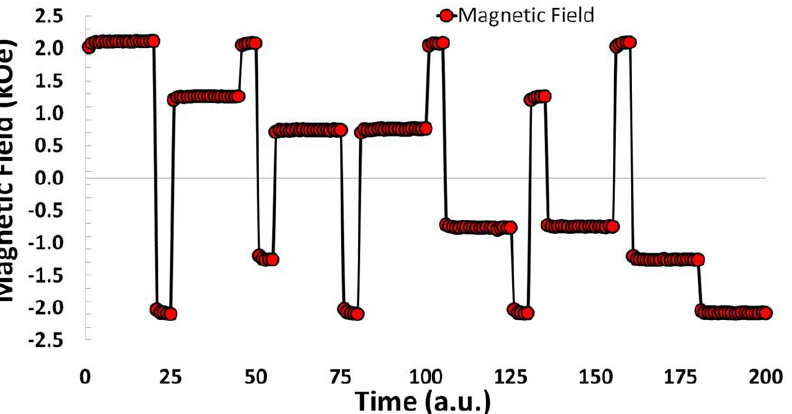
Figure 5. Modulated recording field. The sequence of magnetic fields applied to the triple-stack ML-3D media. The transitional external fields required to achieve the desired magnetic state were given 5 time units while 20 time units were designated for the final magnetic